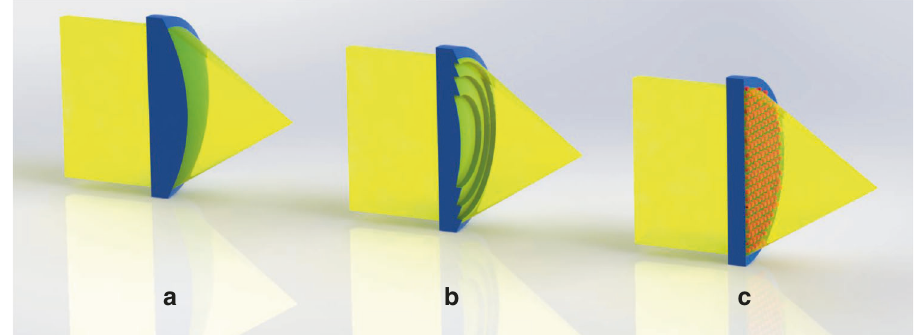
Fig. 1 Artistic cross-sectional sketch of lens types. a Conventional bulky refractive lens b Diffractive lens showing fl attening by division into radial zones c Metalens showing nanoantennas for phase control.